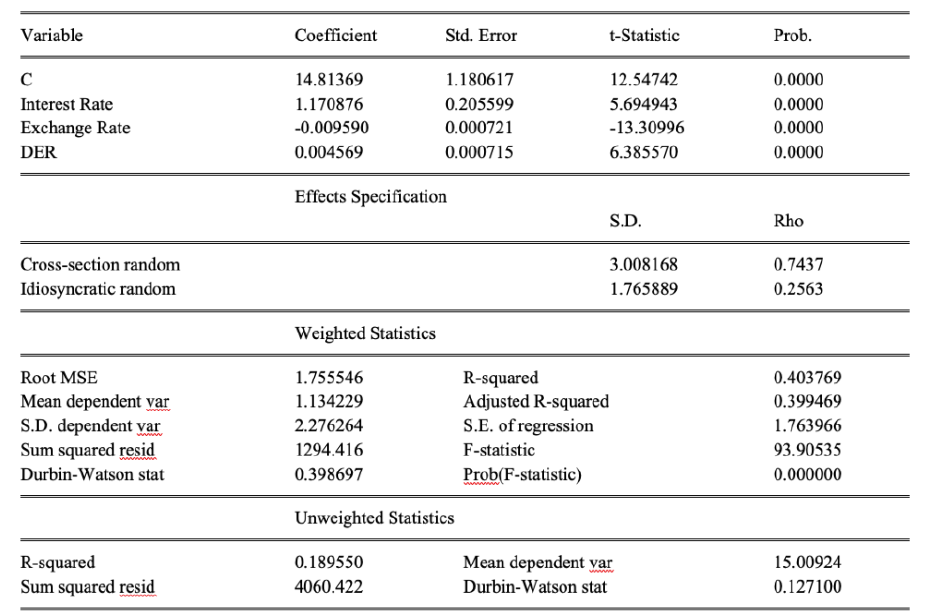
Table 5: Panel Data Regression Model (Random Effect Model)